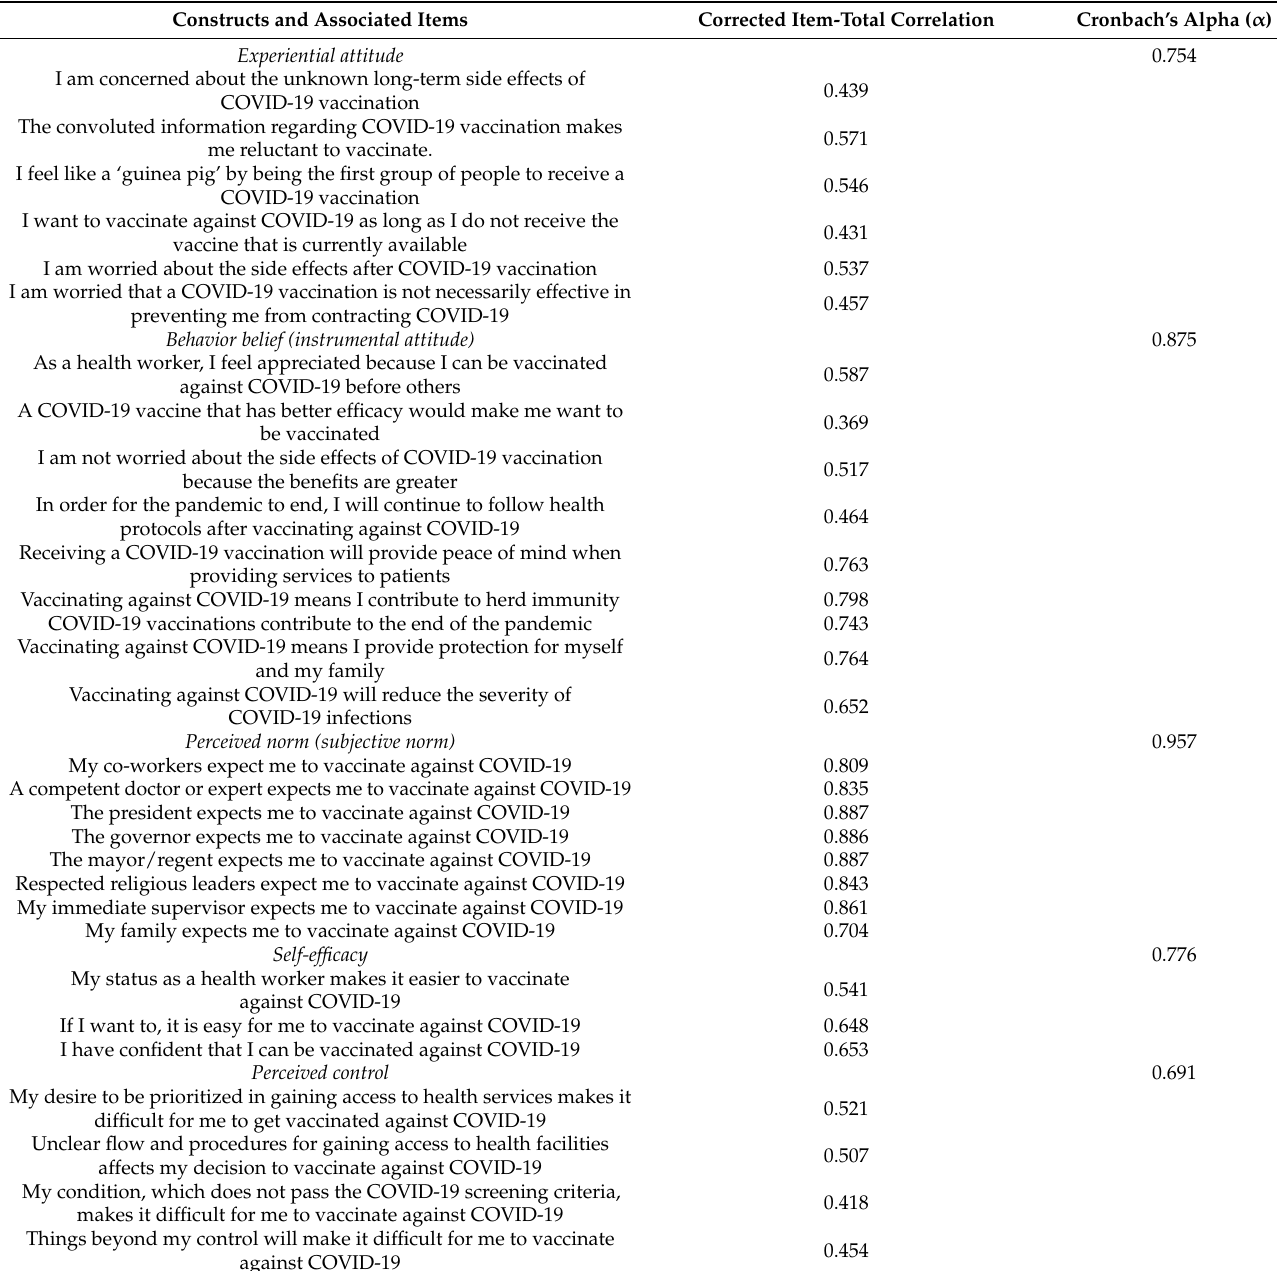
Table 2. IBM construct beliefs associated with COVID-19 vaccination